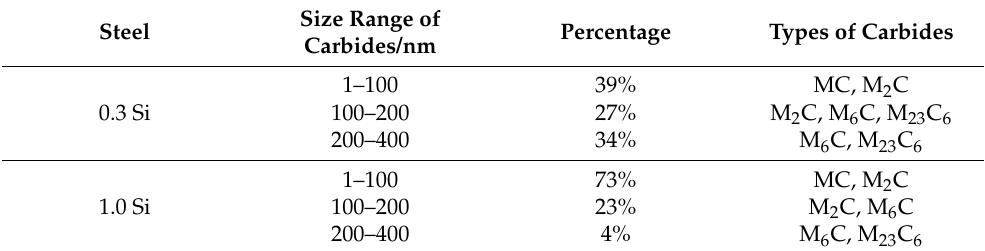
Figure 10. Average particle size distribution of tested steels. Table 2. Carbide size, percentage and type for tested steels tempered for 64 h at 650 °C. Steel